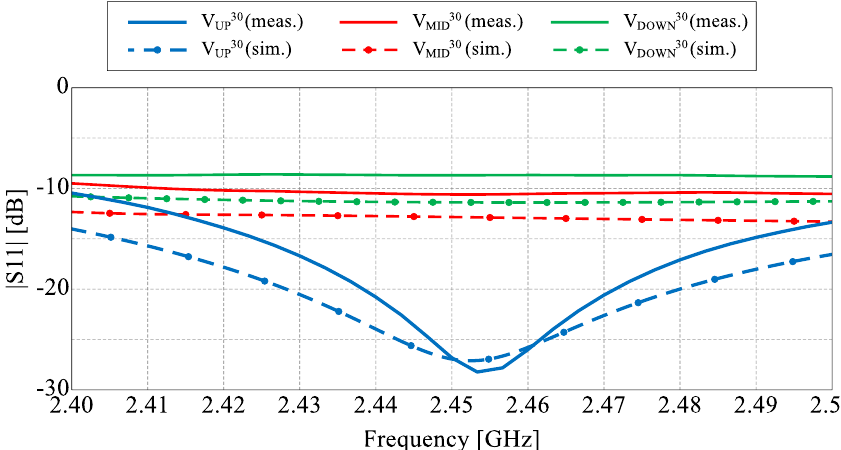
Figure 5. Values of |S11| for all three considered configurations.